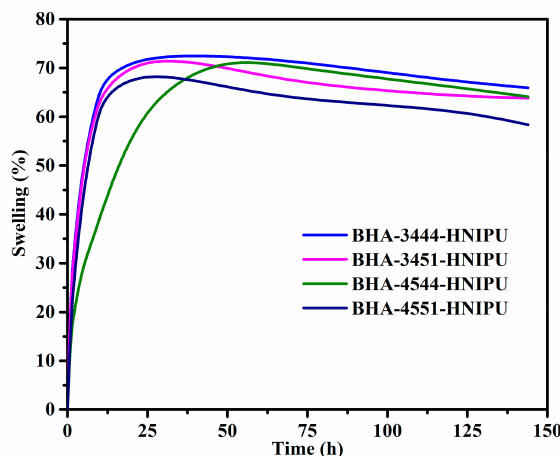
Figure 16. Swelling of HNIPUs.